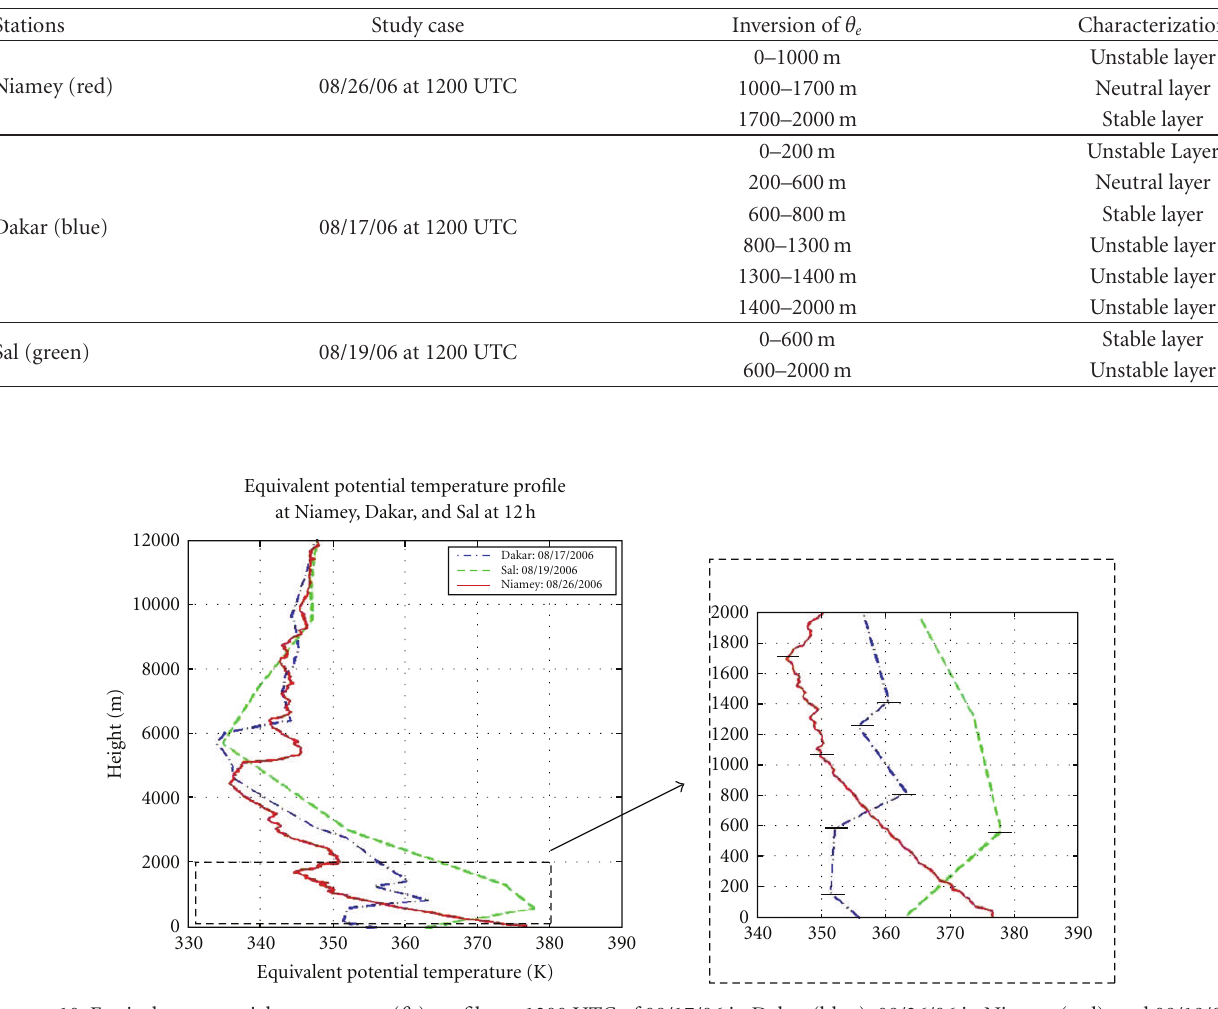
Figure 10: Equivalent potential temperature ( θ e ) profiles at 1200 UTC of 08/17/06 in Dakar (blue), 08/26/06 in Niamey (red), and 08/19/06 in Sal